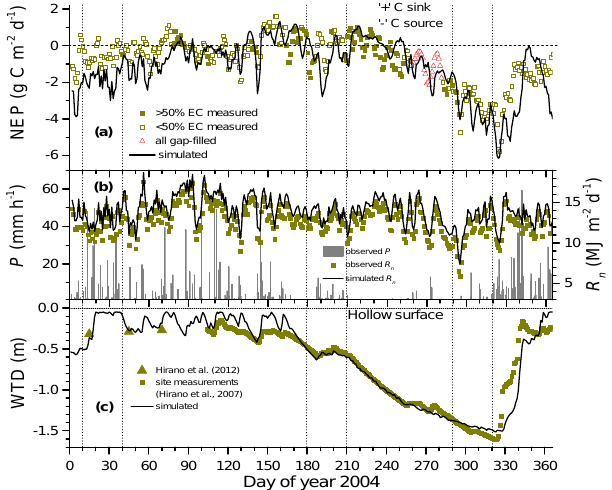
Fig. 4. (a) Three day moving averages of simulated and EC-gap filled estimates of net ecosystem productivity (NEP). Solid squares indicate sums of 24 values more than 1/2 of which were recorded at u ∗ (friction velocity) >0.17ms − 1 , open squares indicate sums of 24 values more than 1/2 of which were gap-filled, and open triangles indicate sums of 24 values all of which were gap-filled; (b) hourly measured precipitation ( P) and three day moving aver- ages of simulated and measured net radiation ( R n ) ; and (c) monthly measured (values digitally obtained from Hirano et al., 2012), daily measured (site measurements mentioned in Hirano et al., 2007) and daily modelled water table depths (WTD) from hollow surface dur- ing 2004 over a drainage affected tropical peat swamp forest at Palangkaraya, Indonesia. Negative values of WTD mean depths be- low the ground.